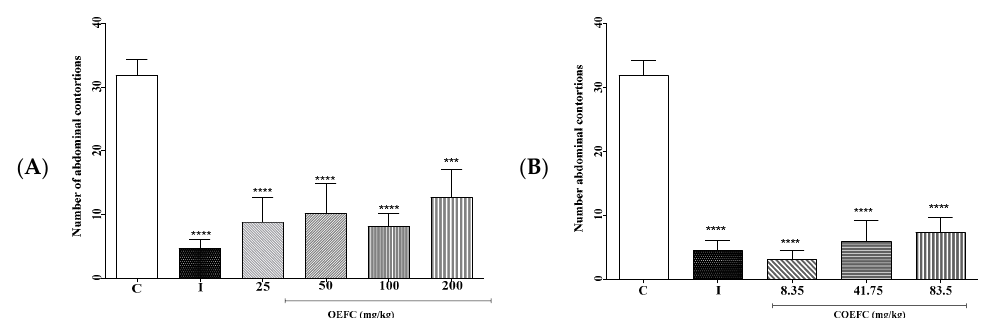
Figure 3. Effect of the OEFC (25, 50, 100, and 200 mg/kg/v.o.) ( A ) and COEFC (8.35, 41.75, and 83.5 mg/kg/v.o.) ( B ) on the number of acetic acid-induced abdominal contortions. Groups: control-C (0.1 mL/10 g/v.o.), indomethacin-I (10 mg/kg/s.c.), OEFC (25, 50, 100, and 200 mg/kg/v.o.) ( A ) and COEFC (8, 35, 41.75, and 83.5 mg/kg/v.o.) ( B ). Values represent the mean ± S.E.M. (standard error of the mean) for groups of 6 animals, where: *** p < 0.001; **** p < 0.0001 when compared to the control group; Statistical analysis: ANOVA followed by Dunnett’s Test with multiple comparisons.